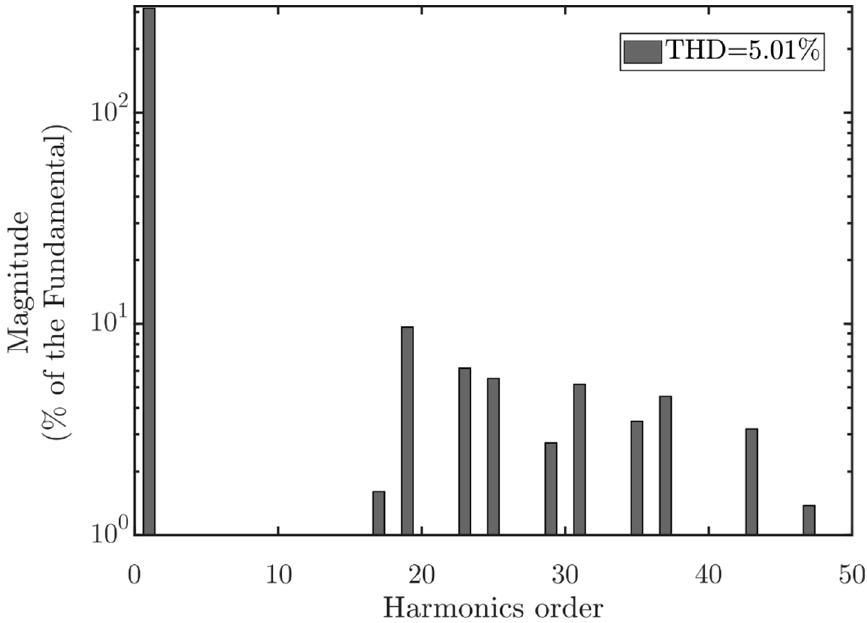
Figure 18. Fourier transform spectrum calculated from the JSOA set of angles described in Table 12.